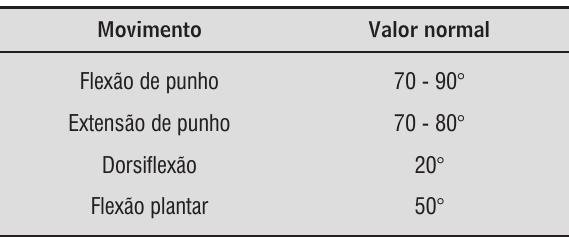
Tabela 4 - Valores normais para a amplitude articular de punho e